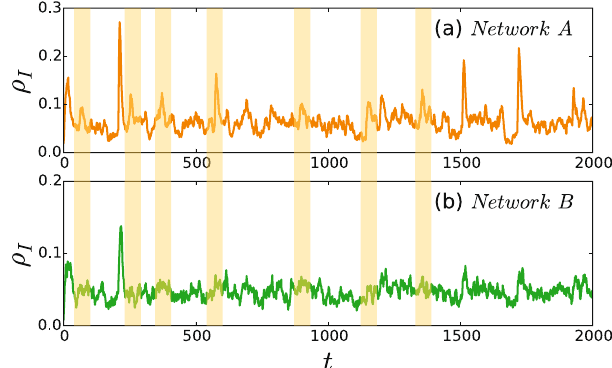
Figure 3. Reproduced time series of recurrent epidemics in the two-layered network model. ( a ) and ( b ) represent the evolutions of the infected density ρ I in the two-layered networks and A B , respectively, where the parameters are taken as 〈 k a 〉 = 6.5, 〈 k b 〉 = 1.5, 〈 k ab 〉 = 1.0,  β ∼ . . t ( ) (0 1, 0 1 ) 2 , β ab = 0.09, γ = 0.2, δ = 0.02, p 0 = 0.01, and N a = N b =